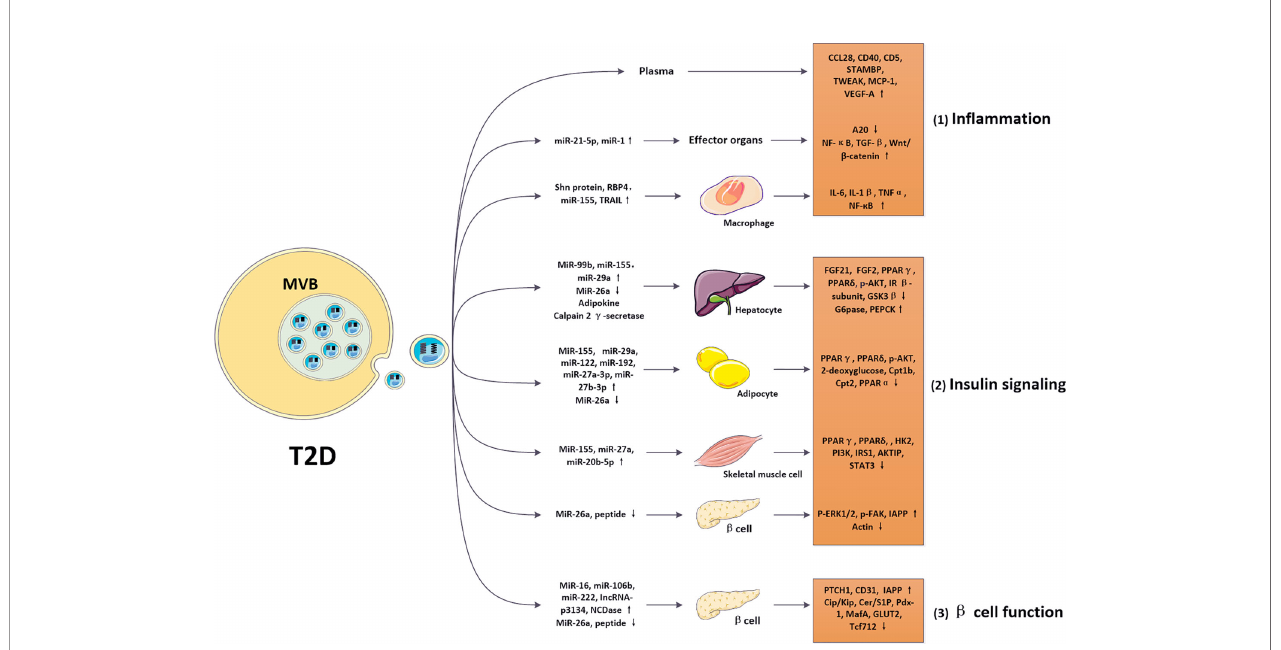
FIGURE 3 | Roles of EVs in regulating diabetic pathological process. In diabetes, altered EVs carrying nucleic acids and proteins can be internalized by various cell types, such as macrophages, adipocytes, hepatocytes, skeletal muscle cells and pancreatic b cells, mediating intercellular communications. 1) Exosomal cargos (such as Shn protein) were modi fi ed in the diabetic model and targeted macrophages via regulating various cytokines (IL-6, IL-1 b , TNF a , and NF- к B). Then, these altered pathways modulated in fl ammatory responses in T2D. 2) Exosomal cargos (such as miR-99b, miR-155, miR-29a, miR-26a, adipokine, and calpain 2 g - secretase) were modi fi ed in the diabetic model and targeted hepatocytes via regulating various cytokines (FGF21, FGF2, PPAR g , PPAR d , p-AKT, IR b -subunit, GSK3 b , G6pase, PEPCK). Exosomal cargos (such as miR-155, miR-29a, miR-122, miR-192, miR-27a-3p, miR-27b-3p, and miR-26a) were modi fi ed in the diabetic model and targeted adipocytes via regulating various cytokines (PPAR g , PPAR d , p-AKT, 2-deoxyglucose, Cpt1b, Cpt2, and PPAR a ). Exosomal cargos (such as miR-155, miR-29a, miR-29c, miR-27a, miR-23b, miR-27b, and miR-20b-5p) were modi fi ed in the diabetic model and targeted skeletal muscle cells via regulating various cytokines (PPAR g , PPAR d , PGC-1 a , HK2, PI3K, IRS1, AKTIP, STAT3, and p53). Exosomal cargos (such as miR-26a, and peptide) were modi fi ed in the diabetic model and targeted b cells via regulating various cytokines (p-ERK1/2, p-FAK, IAPP, and actin). These altered pathways modulated insulin signaling in